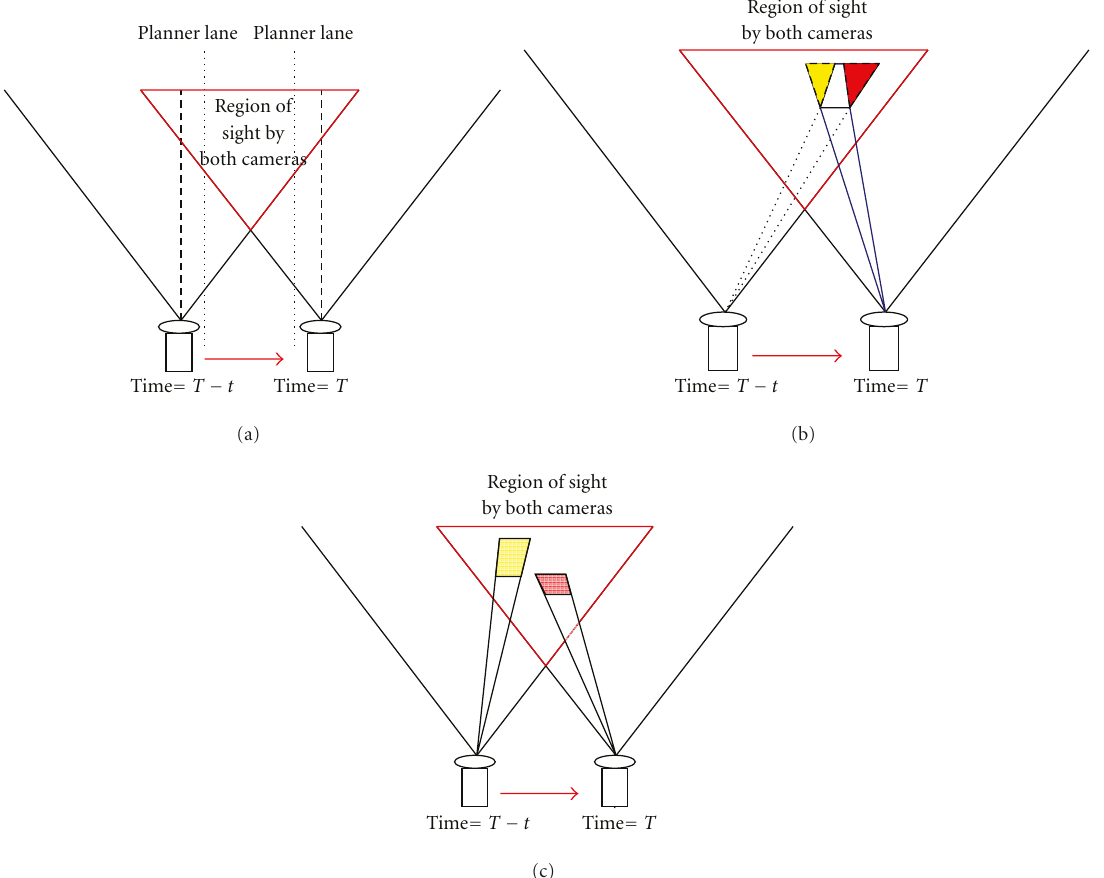
Figure 10: Illustrations for the temporal FLIPM di ff erence image, (a) the planar object patterns and (b) nonplanar object patterns (c) Moving nonplanar object patterns.